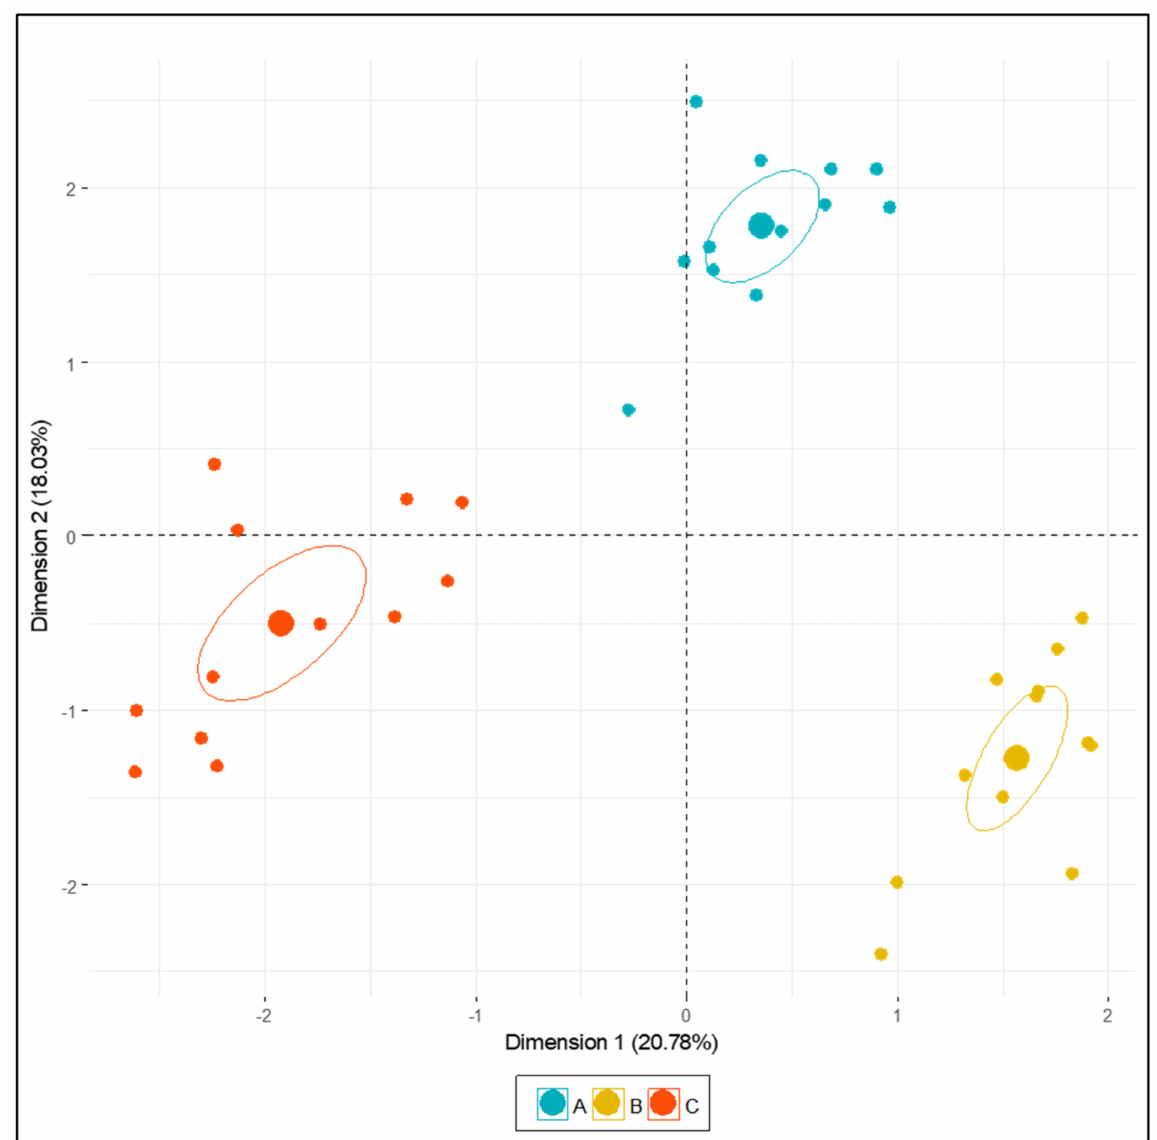
Figure 3. Plot of individuals in the first and second extracted dimension under different storage conditions. A—table eggs stored at average temperature of (11.43 ± 0.20) ◦ C, relative humidity of (79.00 ± 2.94)% and the dew point of (7.90 ± 0.47) ◦ C. B—table eggs stored at average temperature of (3.33 ± 1.1) ◦ C, relative humidity of (57.76 ± 5.30)% and the dew point of ( − 4.25 ± 1.96) ◦ C. C—table eggs stored at average temperature of (20.60 ± 1.04) ◦ C, relative humidity of (43.55 ± 5.93)% and the dew point of (7.60 ± 2.39) ◦